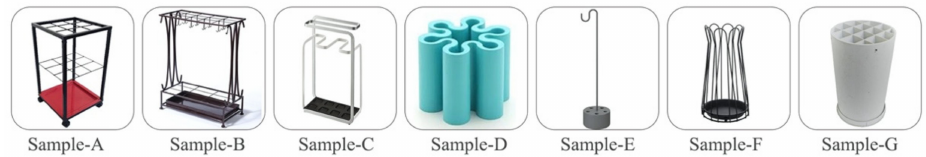
Figure 3. Representative experimental